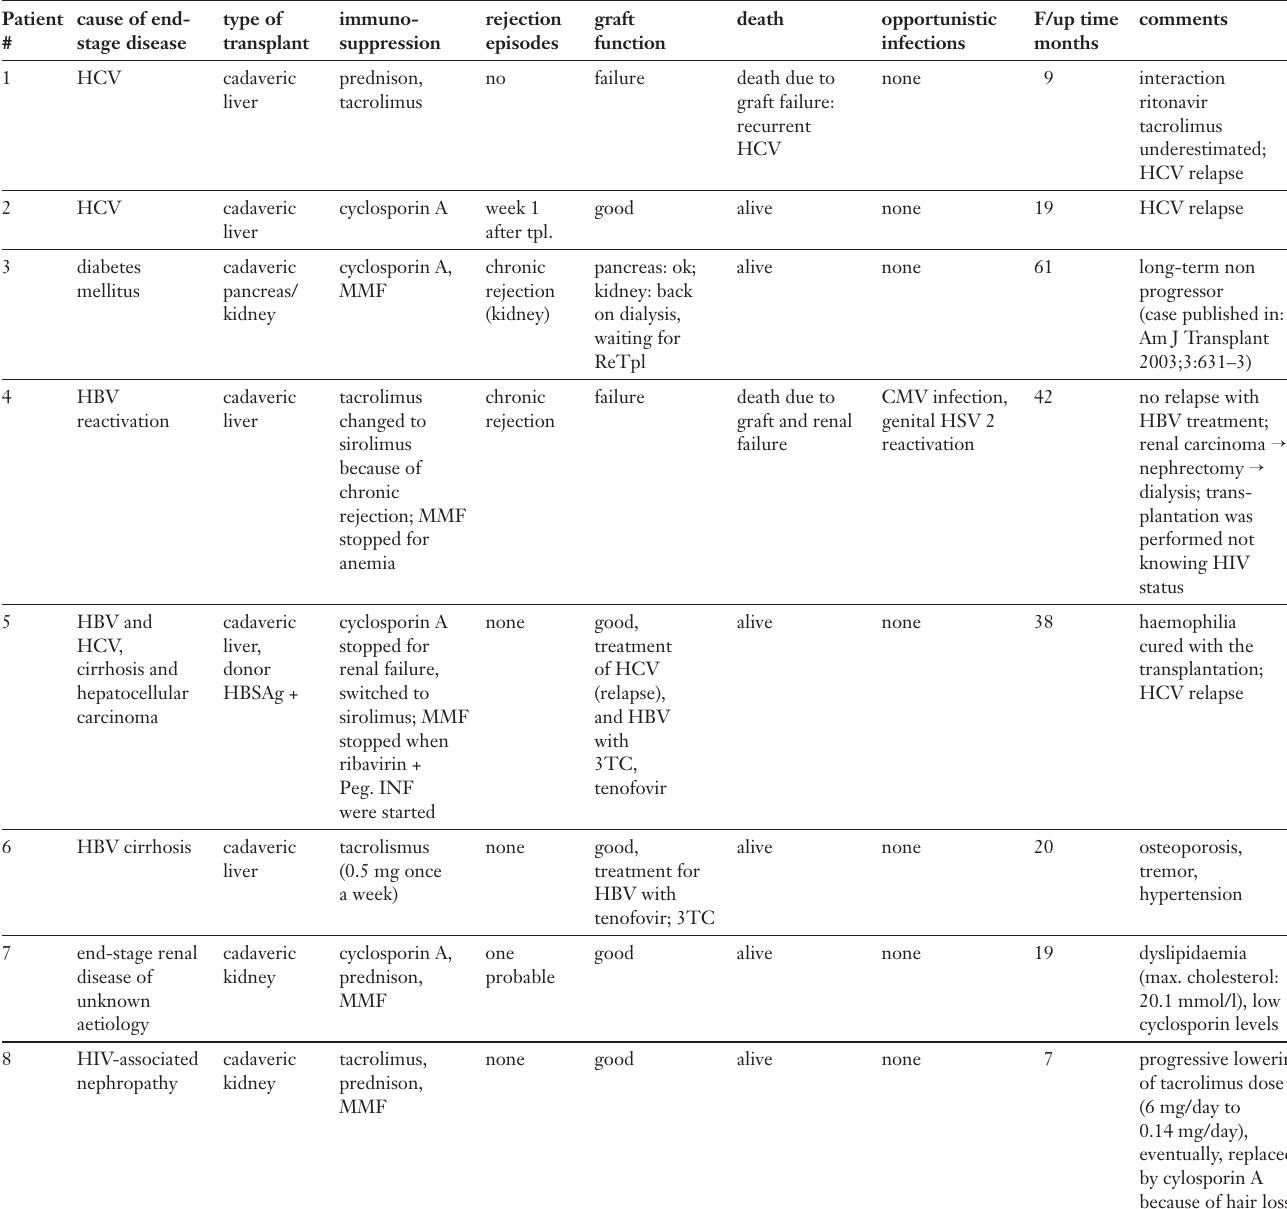
Table 1 Cause of end-stage organ disease, and transplant-related